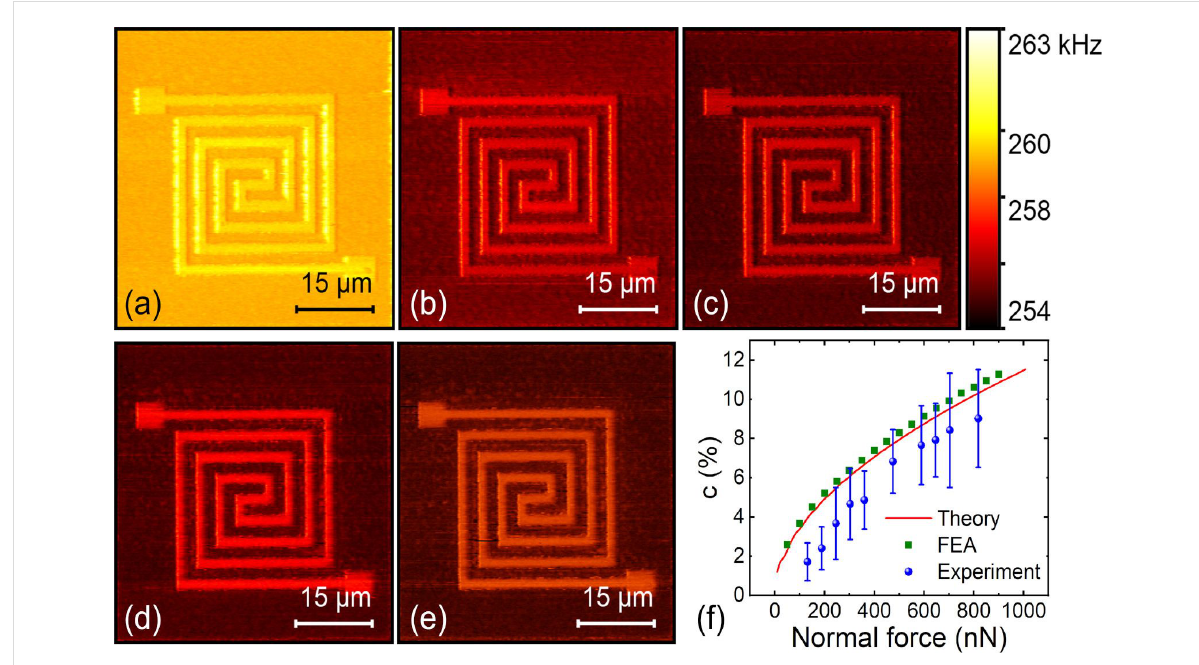
Figure 3: Influence of the applied force on CR-AFM subsurface imaging of the flexible circuit sample with a 52 nm thick top layer. (a–e) The first con- tact resonance frequency images at the applied force of 132, 303, 360, 589, and 646 nN, respectively, using the PPP-FM cantilever. (f) The obtained contact stiffness contrast as a function of normal force from the experiments, theoretical calculations and FEA